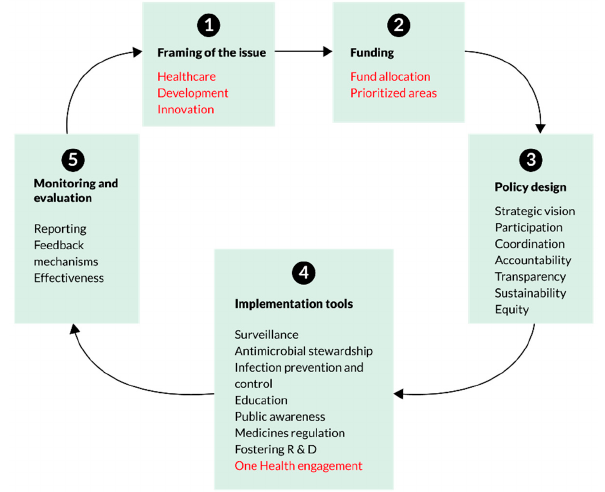
Figure 1. An adapted conceptual framework for assessment of National Action Plans [20].